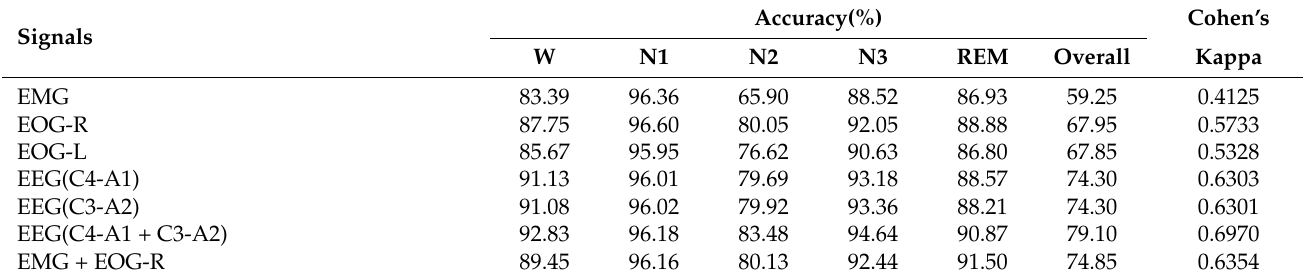
Table 4. Classification performance using different combinations of channels for classifying five sleep stages using